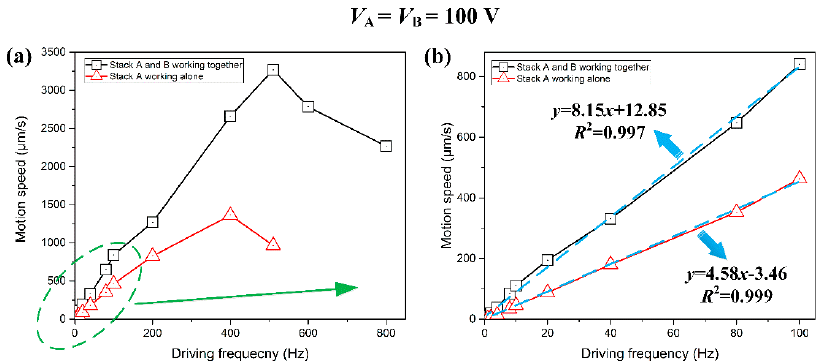
Figure 12. ( a ) Illustration of the motion speed under various driving frequencies; ( b ) illustration of the partial enlarged drawing of motion speed under low driving frequency: 1–100 Hz.